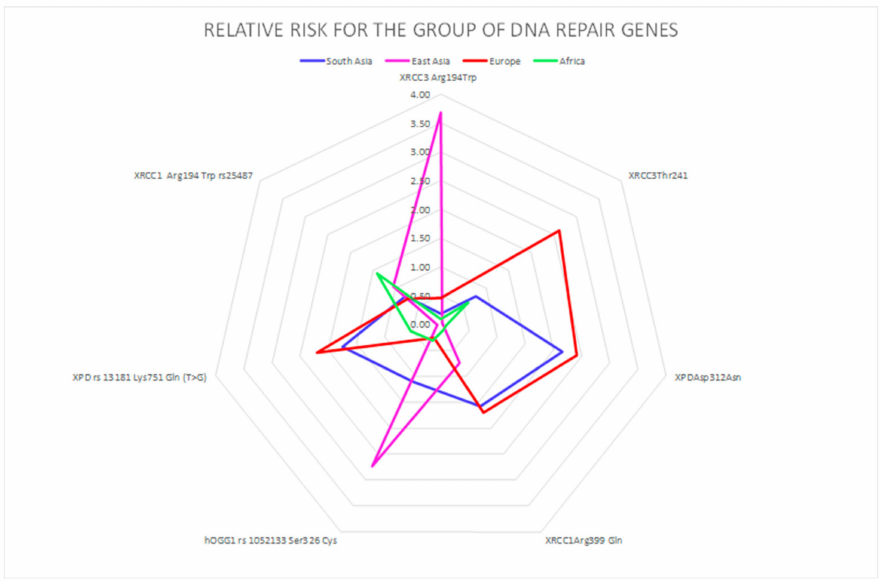
Figure 4. DNA repair polymorphic genes are highlighted with di ff erent colors in the four ethnic groups. The genes are represented by geometrical figures, where the tip of figure points toward the most susceptible genes belonging to each gene group.